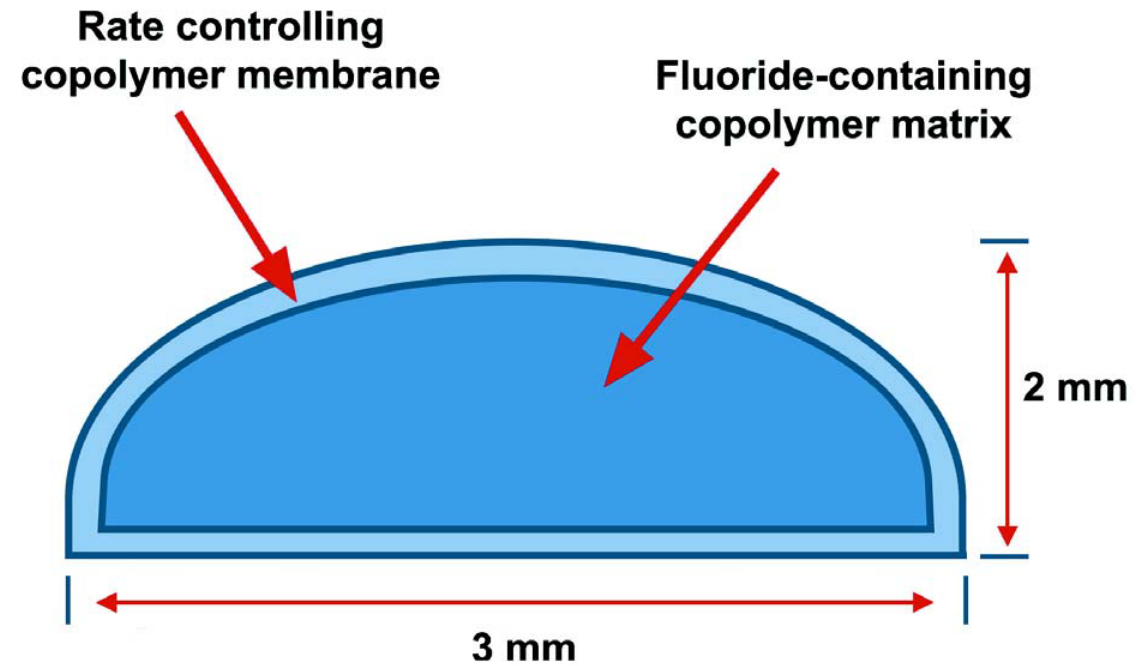
FIGURE 1- Schematic cross-sectional view of the copolymer device, which originally had 8 mm in length, 3 mm in width, and 2 mm in tickness. Modified from Mirth, et al . (1982)